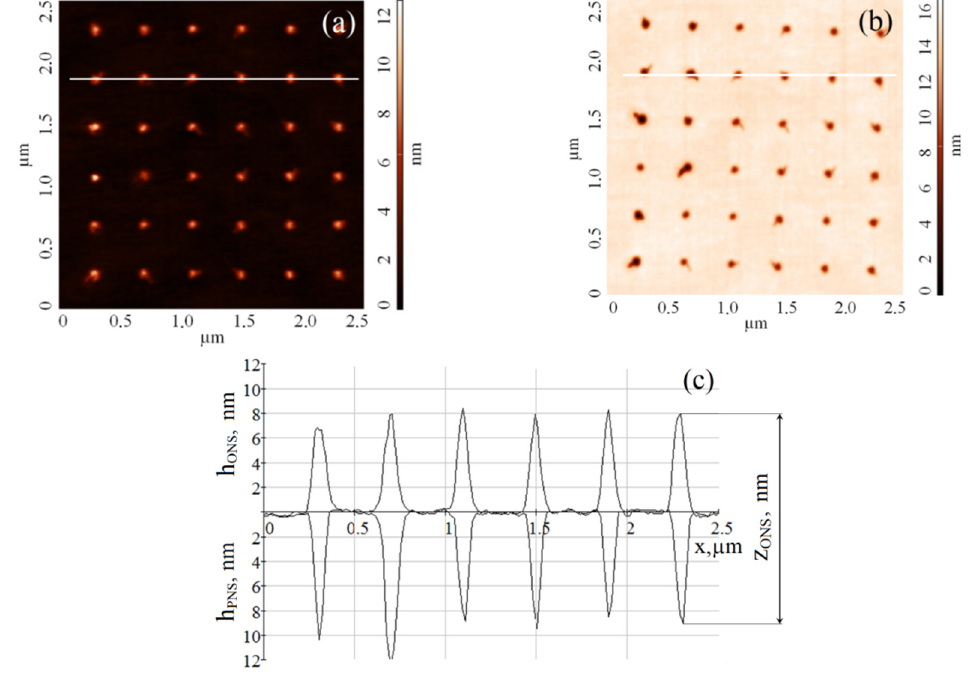
Figure 1. AFM image of the GaAs surface: ( a )—after the formation of ONS by the LAO method; ( b )—after the formation of the PNS; ( c )—AFM cross-section along the lines on a and b. For statistical processing of the obtained AFM images, the Image Analysis 3.5 software package was used. Based on the statistical data obtained, the dependences of the geometric parameters of the ONS (height and diameter) and PNS (depth and diameter) on the amplitude, pulse duration of the applied voltage, and the SetPoint parameters were plotted for the relative humidity of 70 ± 1% and 90 ±